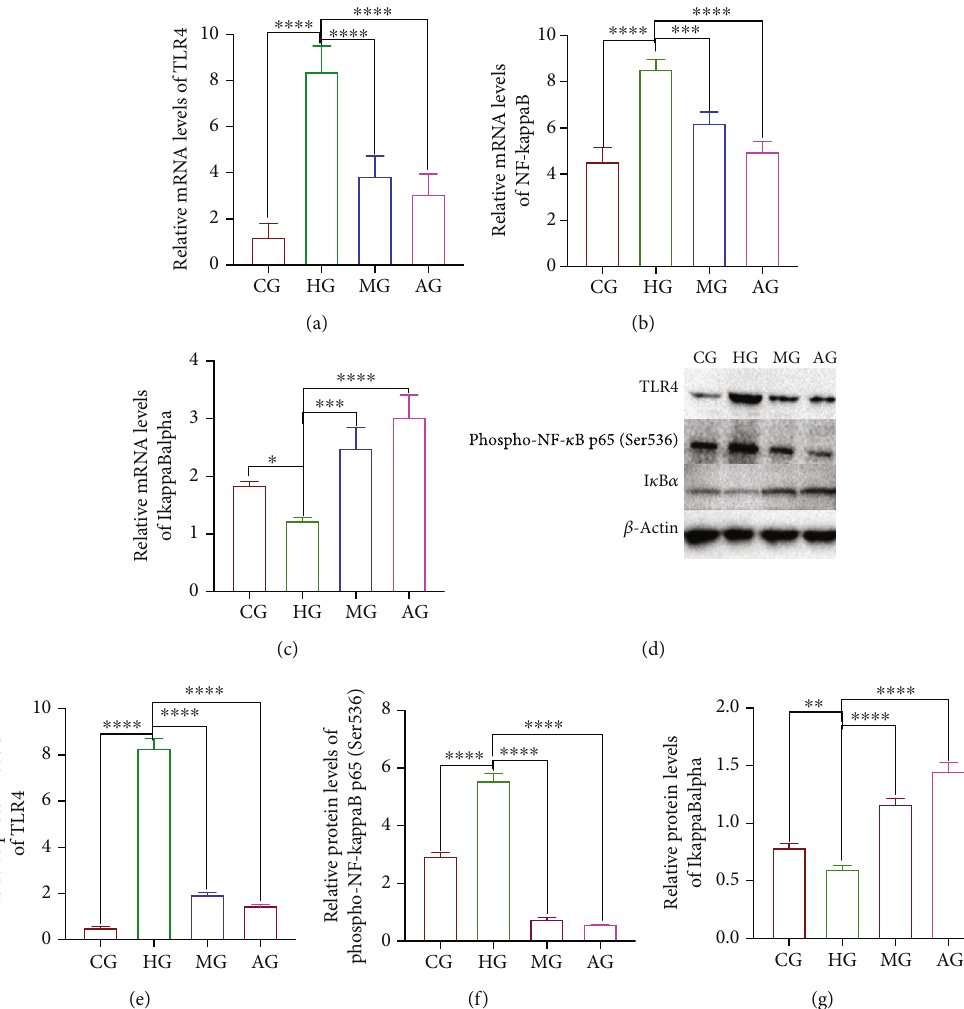
Figure 9: The levels of TLR4, NF- κ B, and I κ B α . (a) Relative mRNA levels of TLR4. (b) Relative mRNA levels of NF- κ B. (c) Relative mRNA levels of I κ B α . (d) Western Blot. (e) Relative protein levels of TLR4. (f) Relative protein levels of phospho-NF- κ B p65 (Ser536). (g) Relative protein levels of κ B α . n = 3 for each group, and ∗ P < 0 : 05 , ∗∗ P < 0 : 01 , ∗∗∗ P < 0 : 001 , and ∗∗∗∗ P < 0 : 0001 vs. the HG